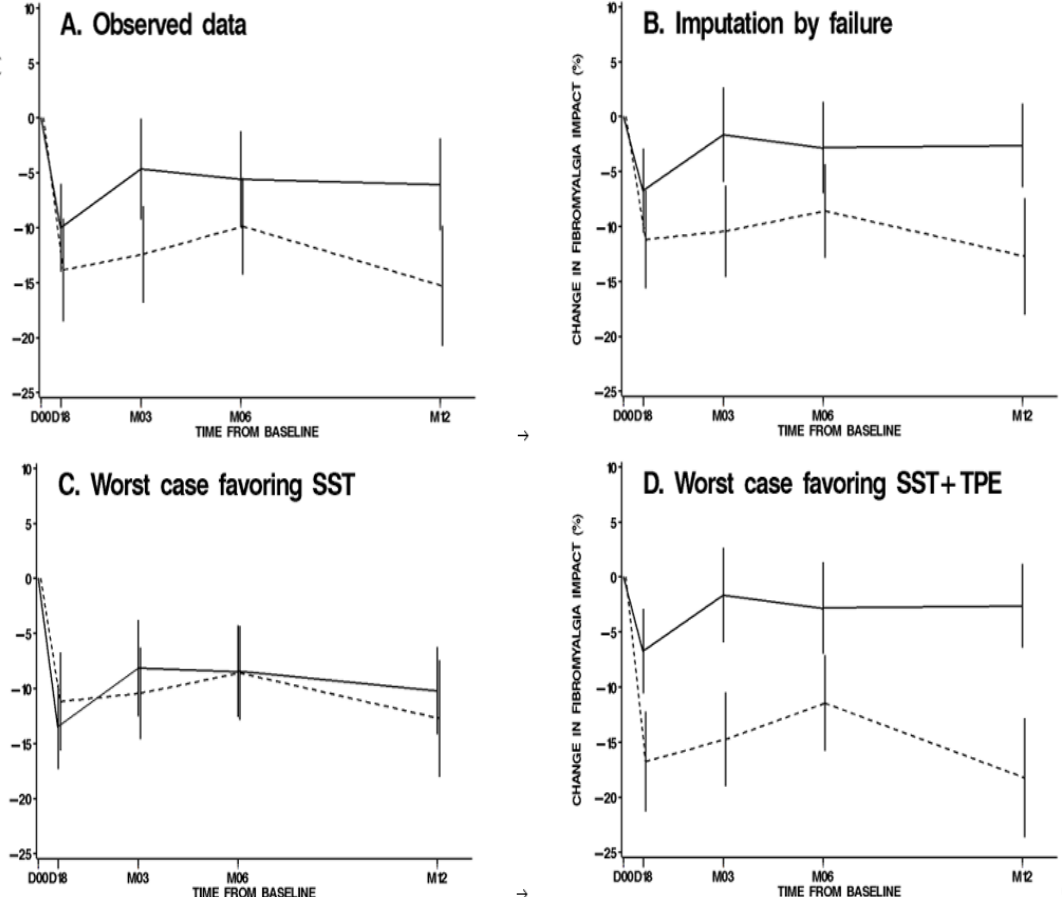
Figure 1. Mean changes from baseline (95% confidence interval) in Fibromyalgia Impact Questionnaire, on intention to treat analysis according to missing values imputation method—FiETT trial, AFRETh. SST (solid line): standard spa therapy; SST + TPE (dashed line): standard spa therapy + therapeutic patient education. Missing values were imputed by decile values observed in the same strategy (1st = success; 9th = failure), as protocoled.